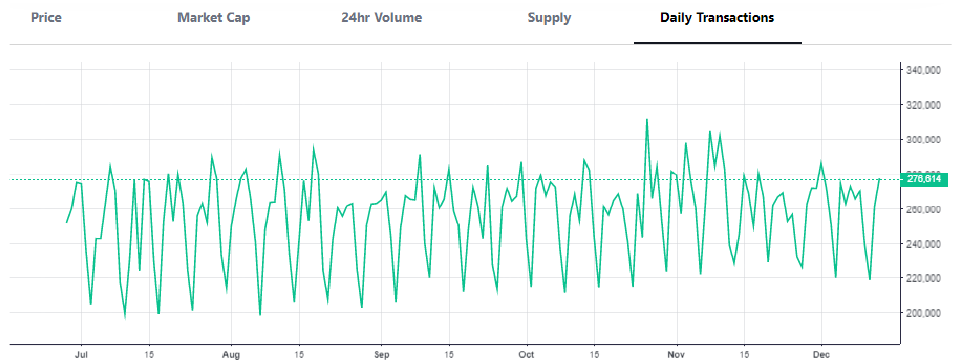
Figure 6. BCH daily transactions as of June 2021 were 72 K, and in December 2022, they reached 276.614 K [10].